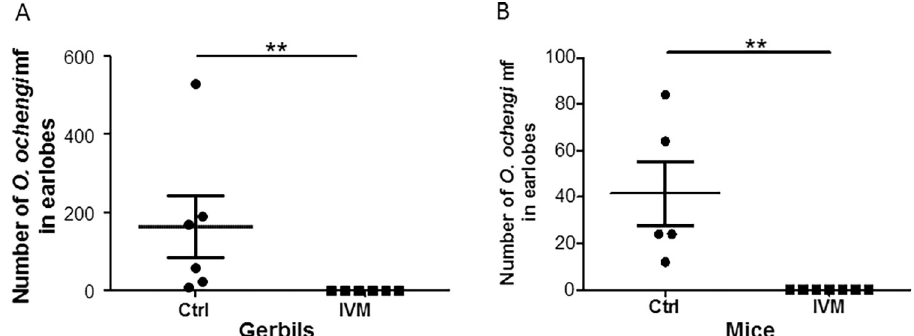
Fig 1. Ivermectin (IVM) completely eliminates O . ochengi mf in gerbils and BALB/c mice. (A) O . ochengi mf (8,000) were injected sc at the nape of each of 12 gerbils and 6 were treated by oral gavage on day 3 with 150 μ g/kg body weight IVM. Control (Ctrl) animals received vehicle (1% DMSO). Animals were sacrificed 30 days post-infection and analyzed for mf in the earlobes, n = 6/group. �� P < 0.01. (B) O . ochengi mf (5,000) were injected sc at the nape of each of 12 mice. Seven were treated with 150 μ g/kg body weight IVM by oral gavage 24 hours post-infection. Control animals received vehicle (1% DMSO in PBS). Animals were sacrificed 8 days post-infection and analyzed for mf in the earlobes. Male and female animals were used. n = 5-7/group, �� P < 0.01. https://doi.org/10.1371/journal.pntd.0011135.g001 heart tissue (11.07 ± 3.11%) was slightly lower mf than that in the lungs (14.00 ± 1.57%) 2.5 days post-infection (Fig 2B). The variation in mf recovery was higher in the heart than in the lungs at 2.5 days post-infection. Treatment of BALB/c mice with a single dose of IVM 12 hours after infection, significantly decreased the number of L . loa mf in the lungs and in cardiac blood after 2 days (Fig 3). The number of mf in the lungs was significantly reduced from 4,258 ± 895 in the control group to 657 ± 124 and 441 ± 105 in the 1 and 10 mg/kg body weight IVM groups respectively (Fig 3A). This signifies 84.56 and 89.65% reduction of L . loa mf in the groups that received 1 and 10 mg/ kg body weight IVM respectively. Similarly, mf in cardiac blood dropped significantly from 85 ± 25 in the control mice to 16 ± 4 and 5 ± 1 in the 1 and 10 mg/kg body weight IVM groups respectively (Fig 3B). This represents 81.63 and 93.76% drop in mf in the 1 and 10 mg/kg body weight IVM groups respectively. In this experiment, the number of mf in the lungs and cardiac blood of control animals was 10.64 ± 2.24 and 4.24 ± 1.32% of the total mf injected. Several exploratory studies with the gerbils following intraperitoneal infection with L . loa mf rarely showed mf in cardiac blood. Large numbers of L . loa mf were found in the Table 2. L . loa microfilariae are recovered in the blood, lungs and heart of BALB/c mice. Mice were intravenously infected with 12,000 L . loa mf and analyzed on day 8 post-infection. Mouse Sex